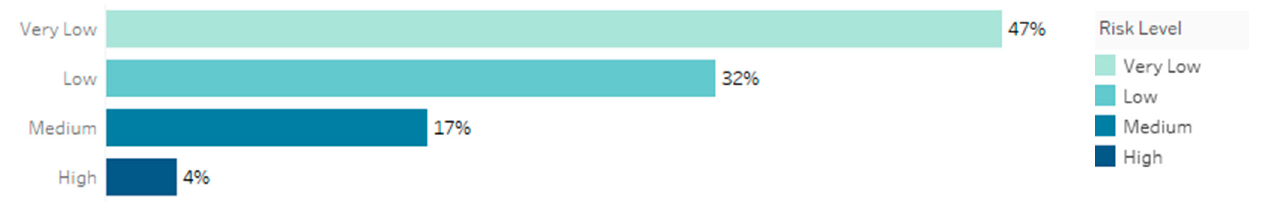
Figure 4. Percentage of injuries by IMS risk rating.